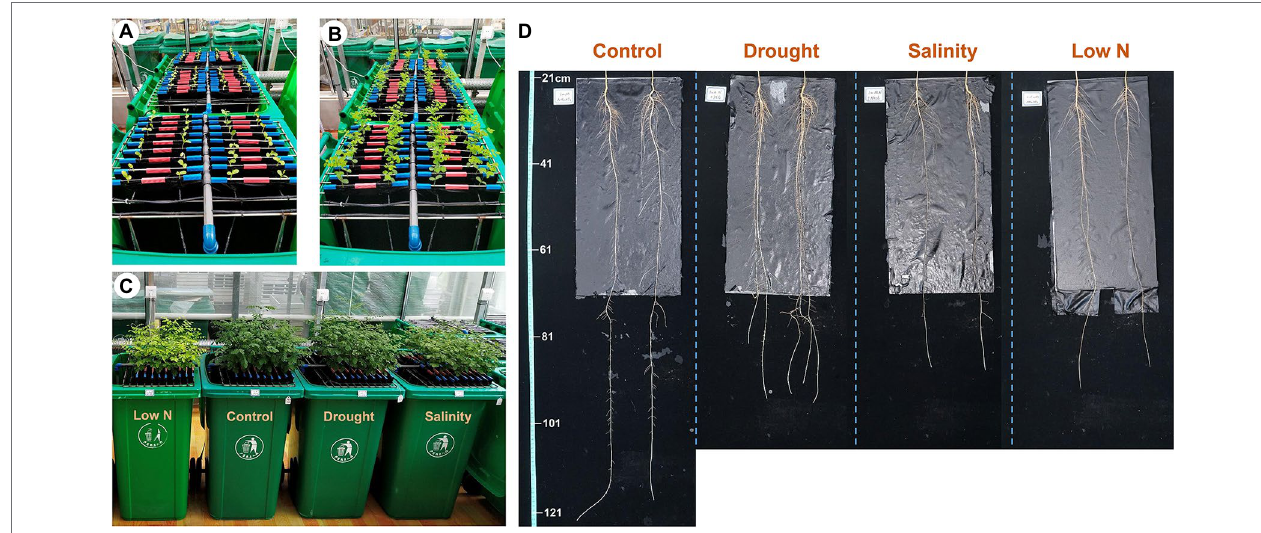
FIGURE 1 | Sophora japonica seedlings grown in a semi-hydroponic phenotyping platform, 1 day (A) and 7 days (B) after transplanting; aboveground growth (C) and root morphology (D) of plants under control, drought, salinity, and low N treatment at